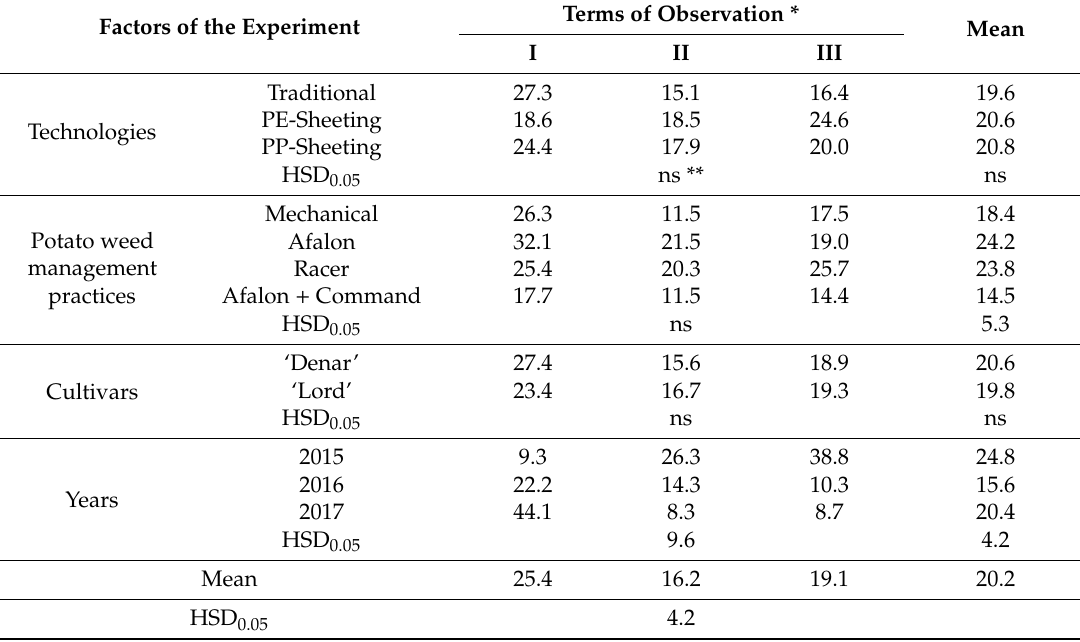
Table 6. The impact of technology, methods of weed management, cultivars, and years on the number of dicotyledonous weeds (PLA / m − 2